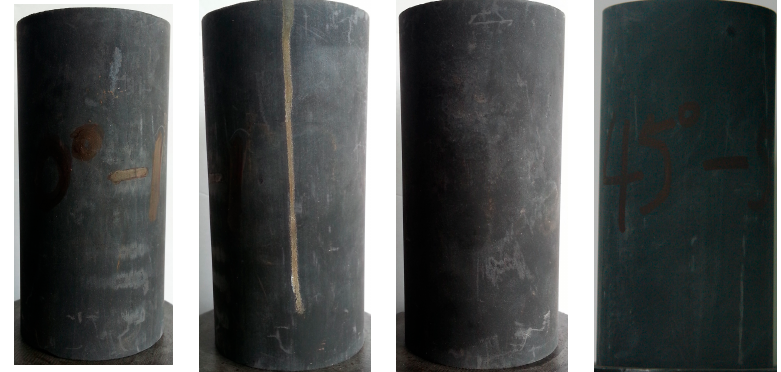
Figure 5. Standard shale samples after processing.